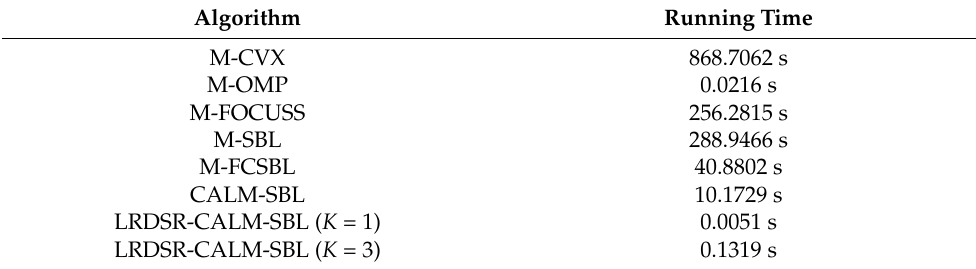
Table 2. Average running time